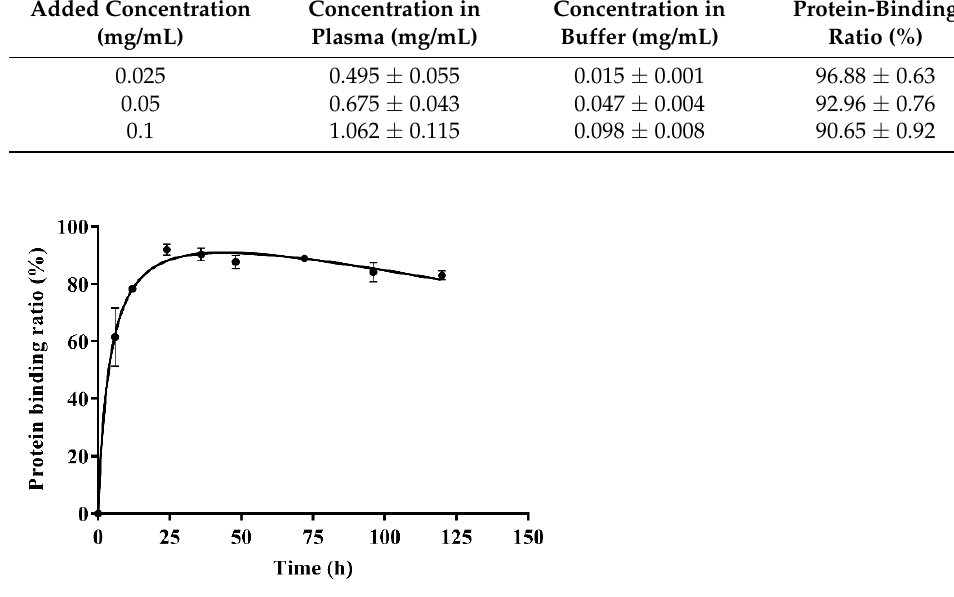
Figure 4. The plasma protein binding ratios of azalomycin F (0.05 mg/mL) at different time points ( n = 3) .